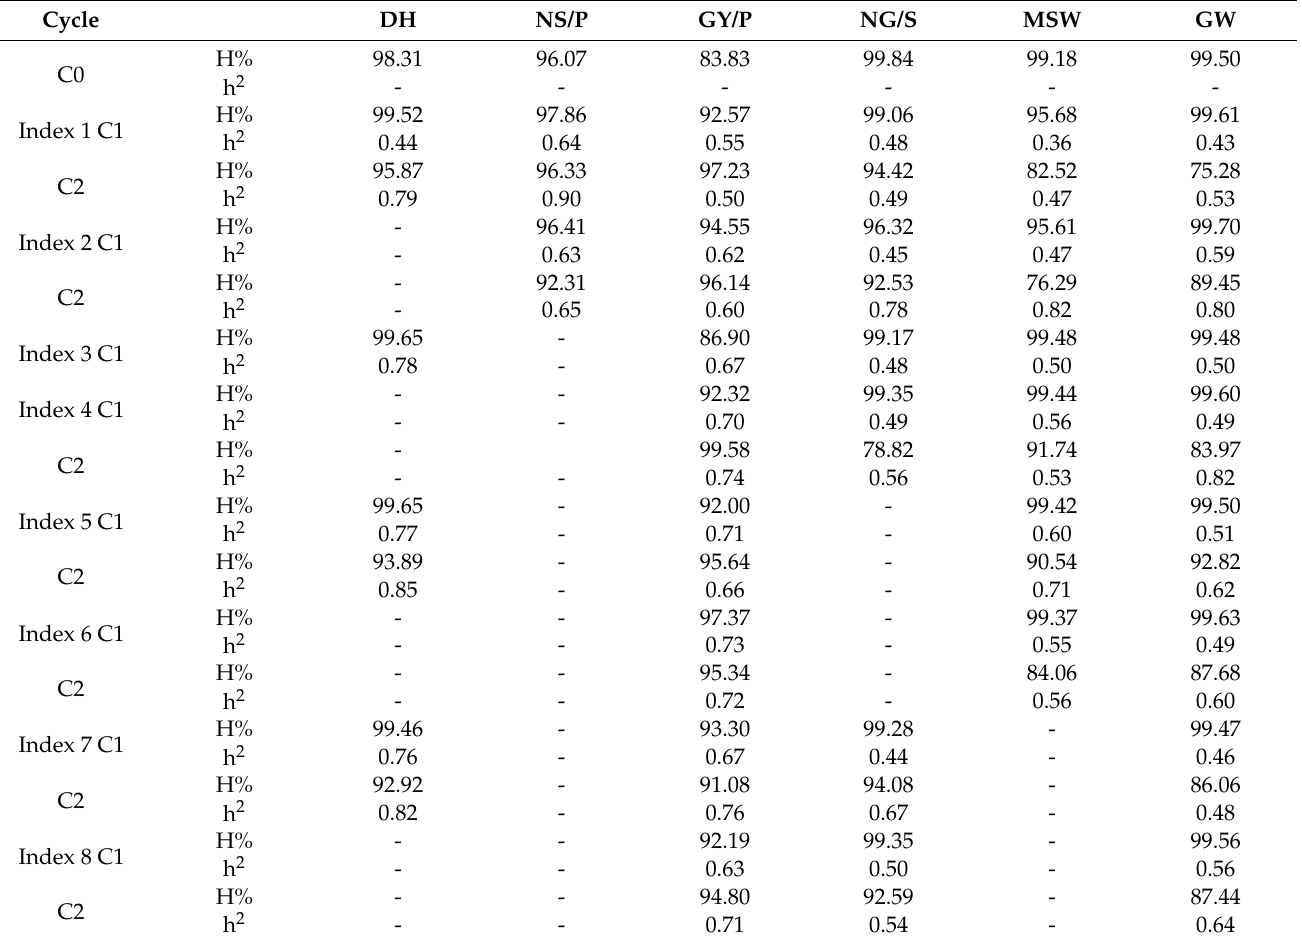
Table 4. Heritability in the broad (H%) and in narrow sense (h 2 ), as estimated from parent–offspring regression for the traits under selection